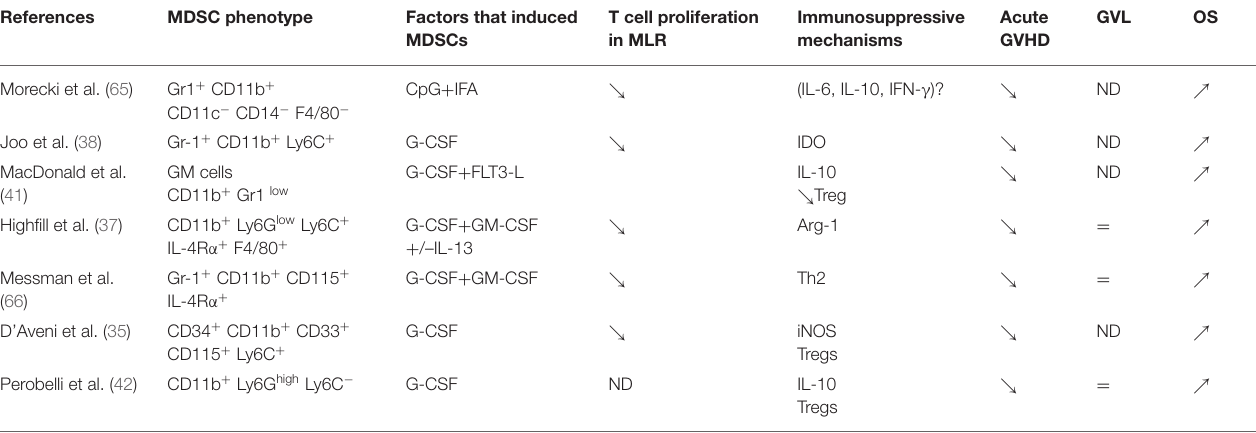
TABLE 3 | MDSCs (cellular therapy) in HSCT mouse models: induction, mechanisms of action, and impact on GVHD, GVL, and